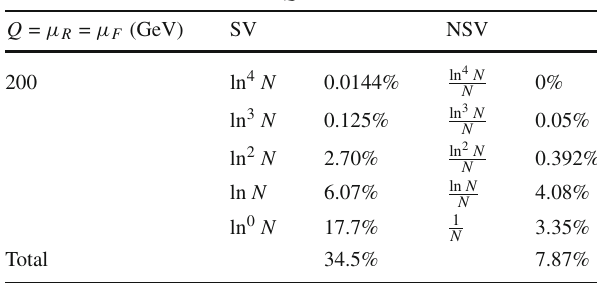
Table 3 % contribution of SV distributions and NSV logarithms to the Born cross section at NNLO for Q = 200 GeV